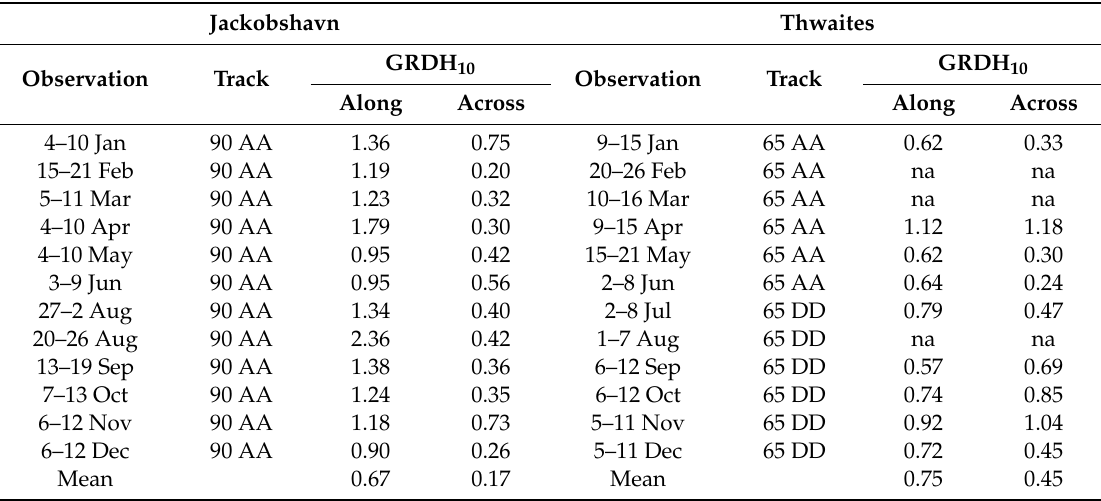
Table 14. RMSE (expressed in m / day) for the displacement velocities calculated with the in-house OT algorithm with respect to reference IW SLC results for JAK (left panel) and THW (right panel). Jackobshavn Thwaites GRDH 10 GRDH 10 Observation Track Observation Track Along Across Along